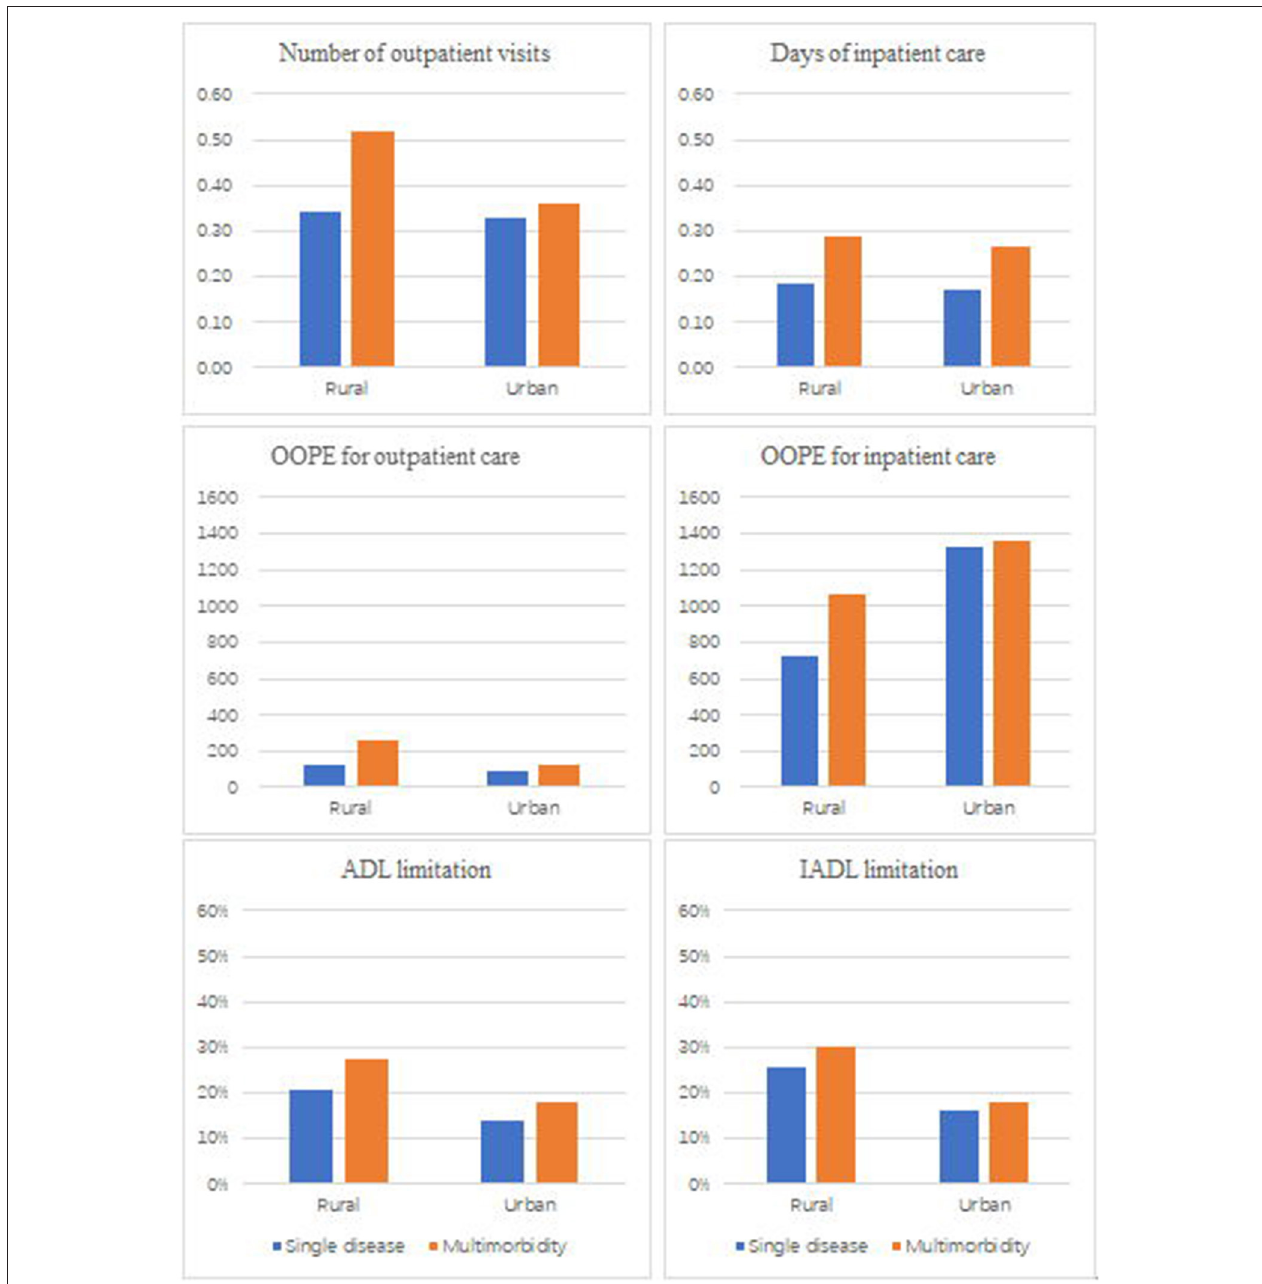
FIGURE 1 | Frequency of healthcare, health expenditure, and functional limitation by the number of disease and residence